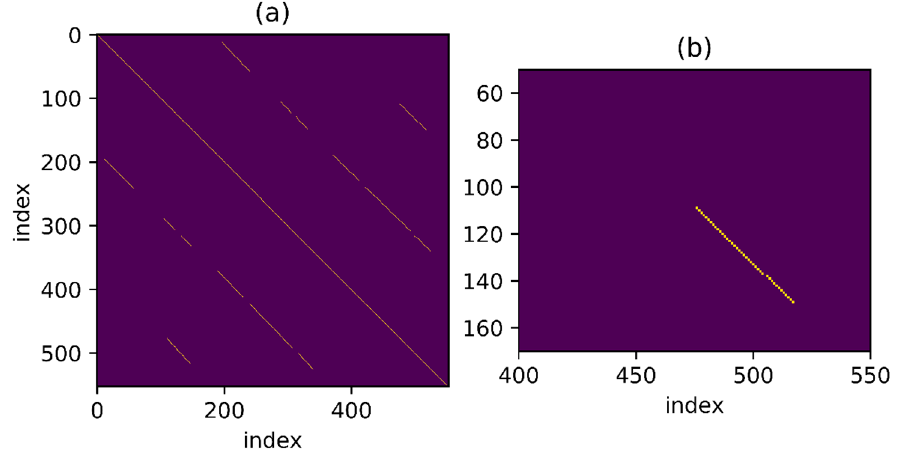
Figure 8. Pairs selected through RANSAC method. ( a ) Pairs selected in the whole process; ( b ) The model-match processed results of the typically connected region in Figure 7.